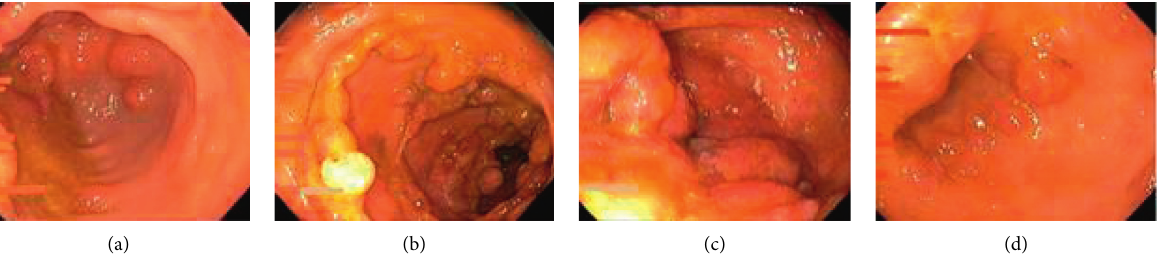
Figure 2: Colonoscopy findings; pancolitis with inflammatory polyps. (a) Rectum, (b) ascending colon, (c) caecum, and (d) terminal ileum.